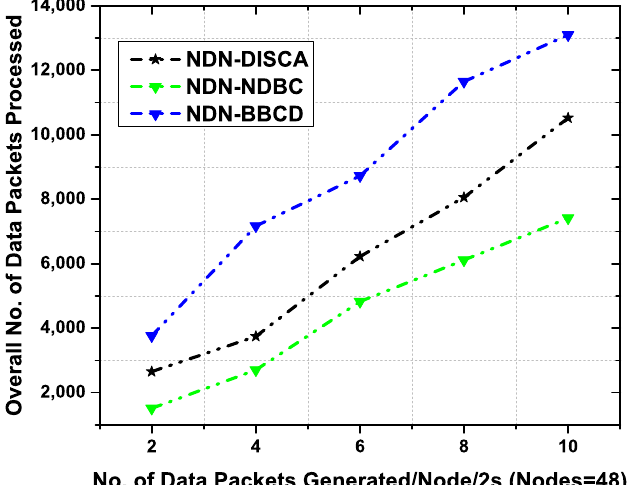
Figure 7. Overall number of data packets processed as a function of number of data packets generated per 2 s with 48 static